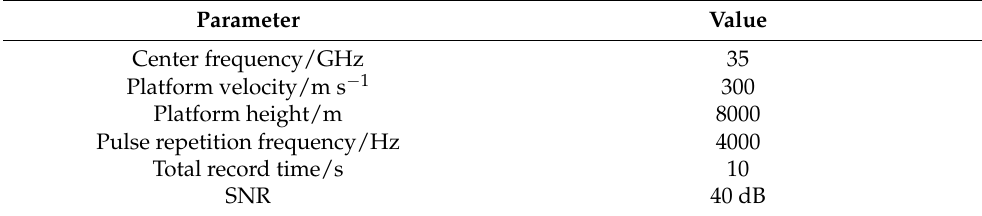
Table 1. The system parameters of simulated Video-SAR.